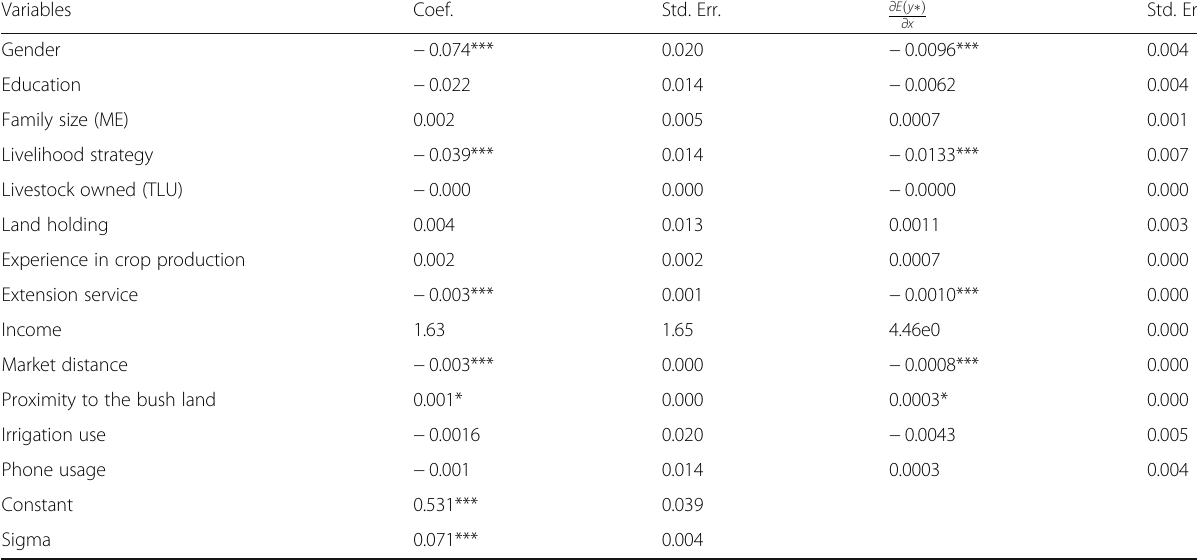
Table 5 Two-limit tobit regression results on households ’ perceptions about P. juliflora Variables